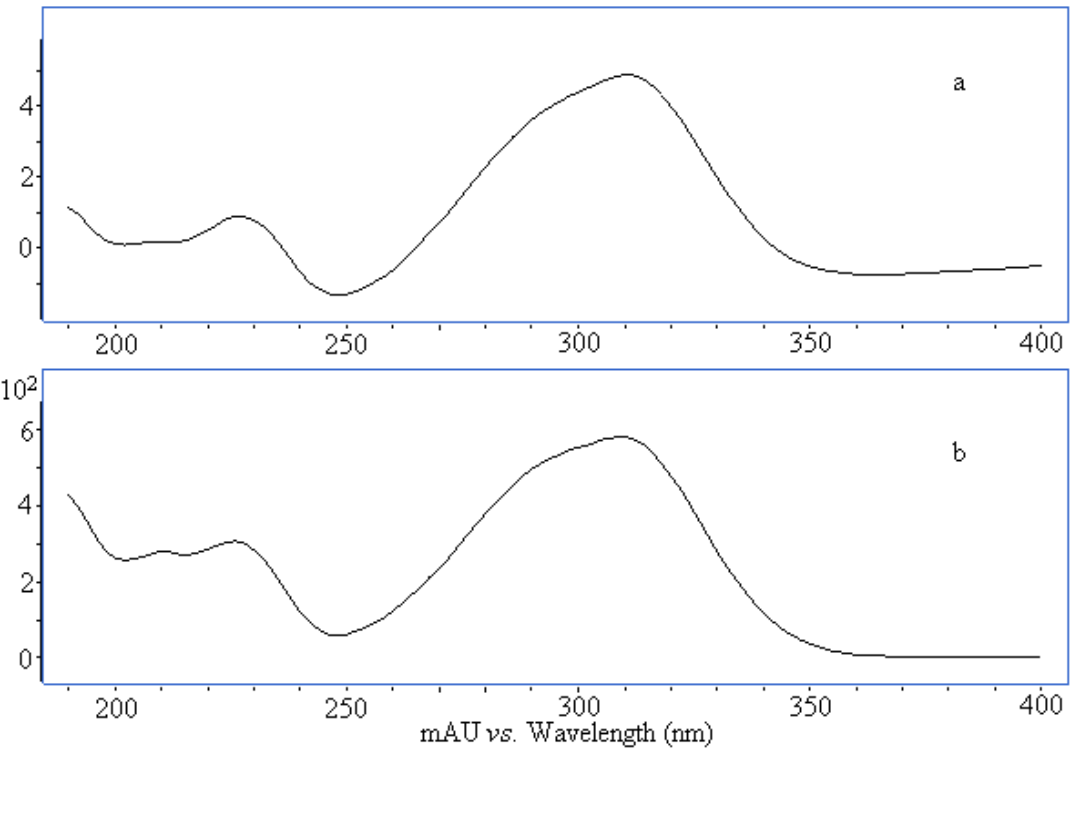
Tentative Identification mDa